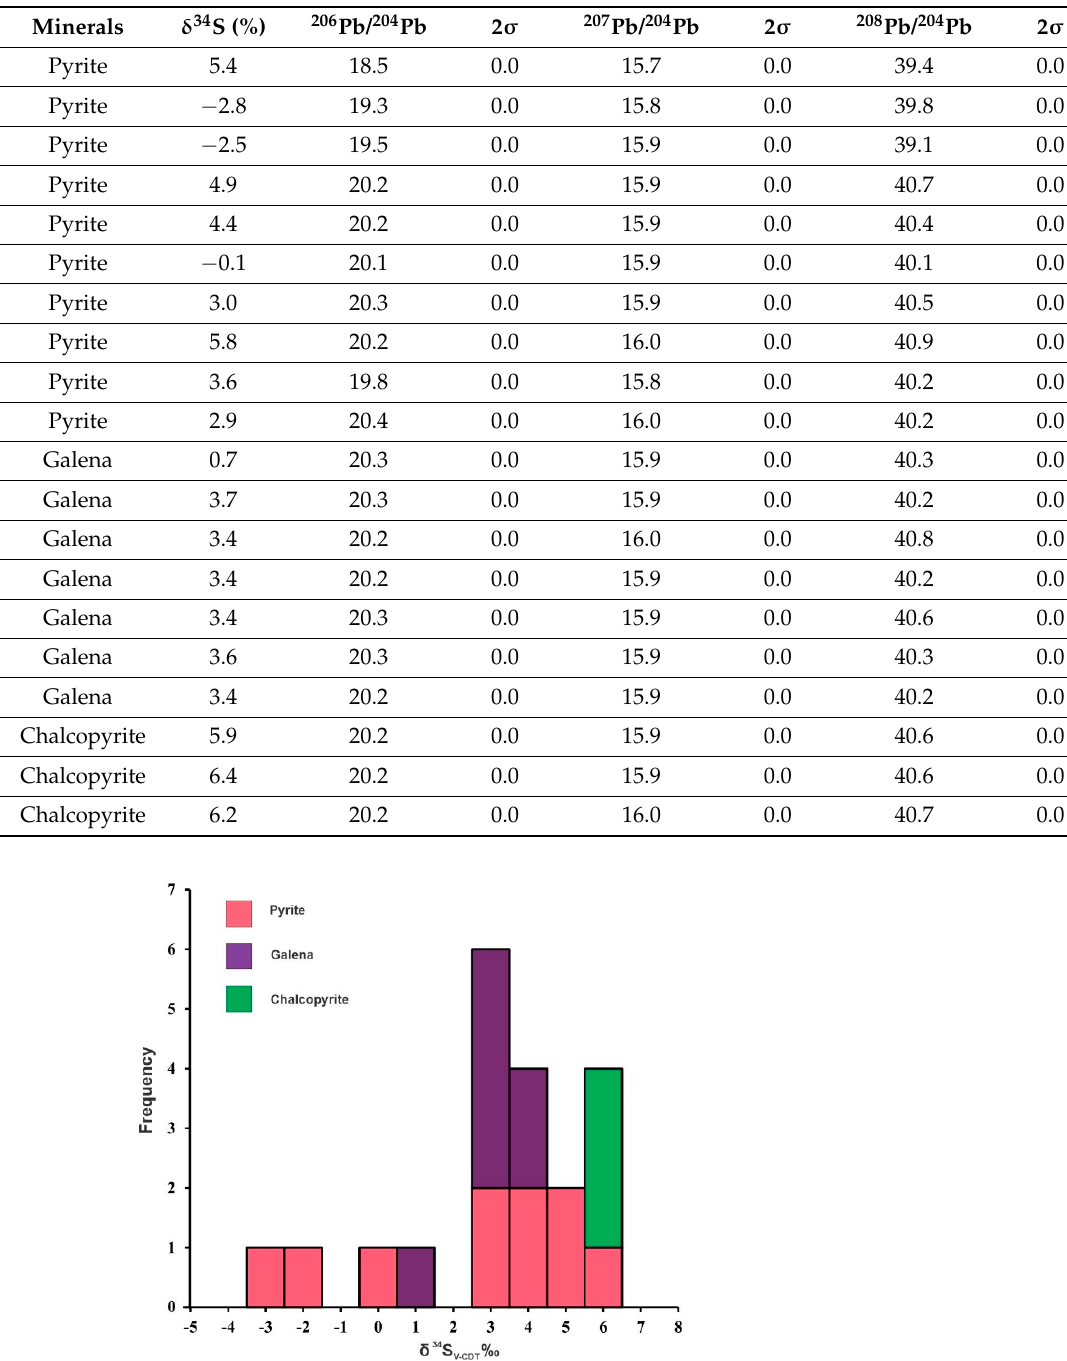
Figure 10. Histogram of the sulfur isotopic compositions of sulfide minerals in the Kargah Cu-Pb polymetallic deposit.